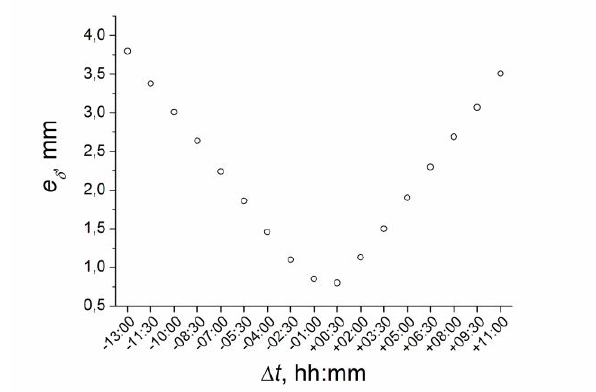
Figure 1. Interpolation accuracy (circles) of TPW fields as function of time discrepancy, see Section